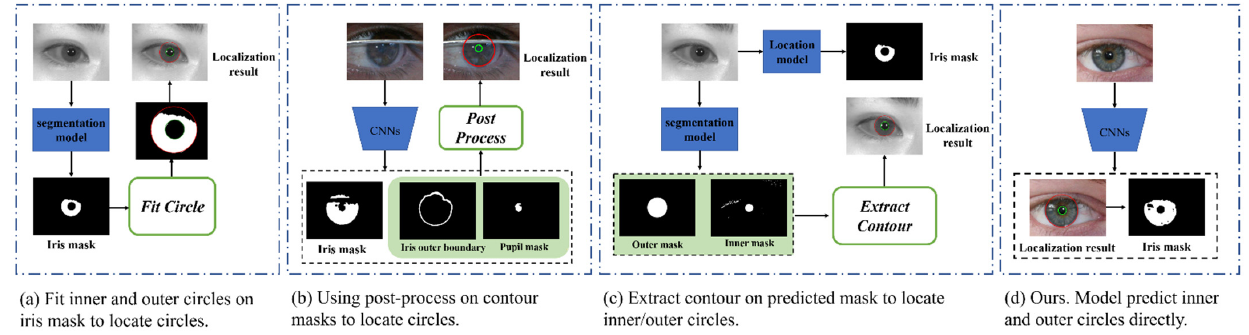
Figure 3. Illustrations of different methods for iris localization.